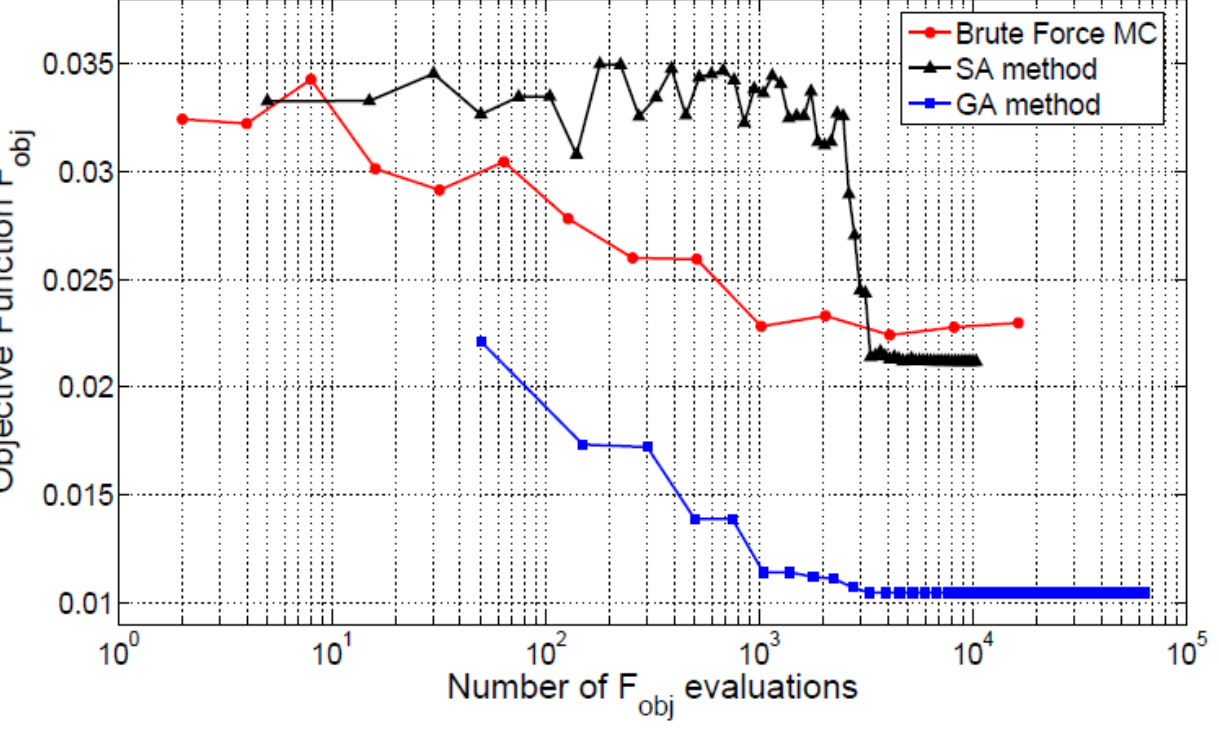
Figure 11. Comparison of various phase-only optimization